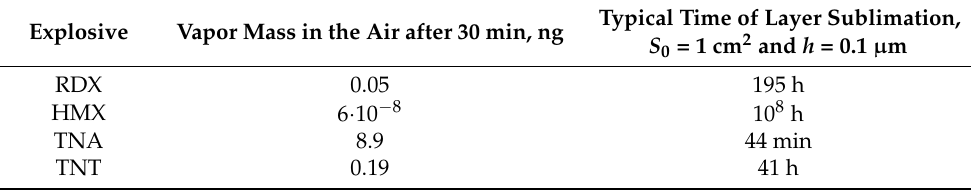
Table 2. Calculated sublimation behaviors of the explosives at T = 293 K.